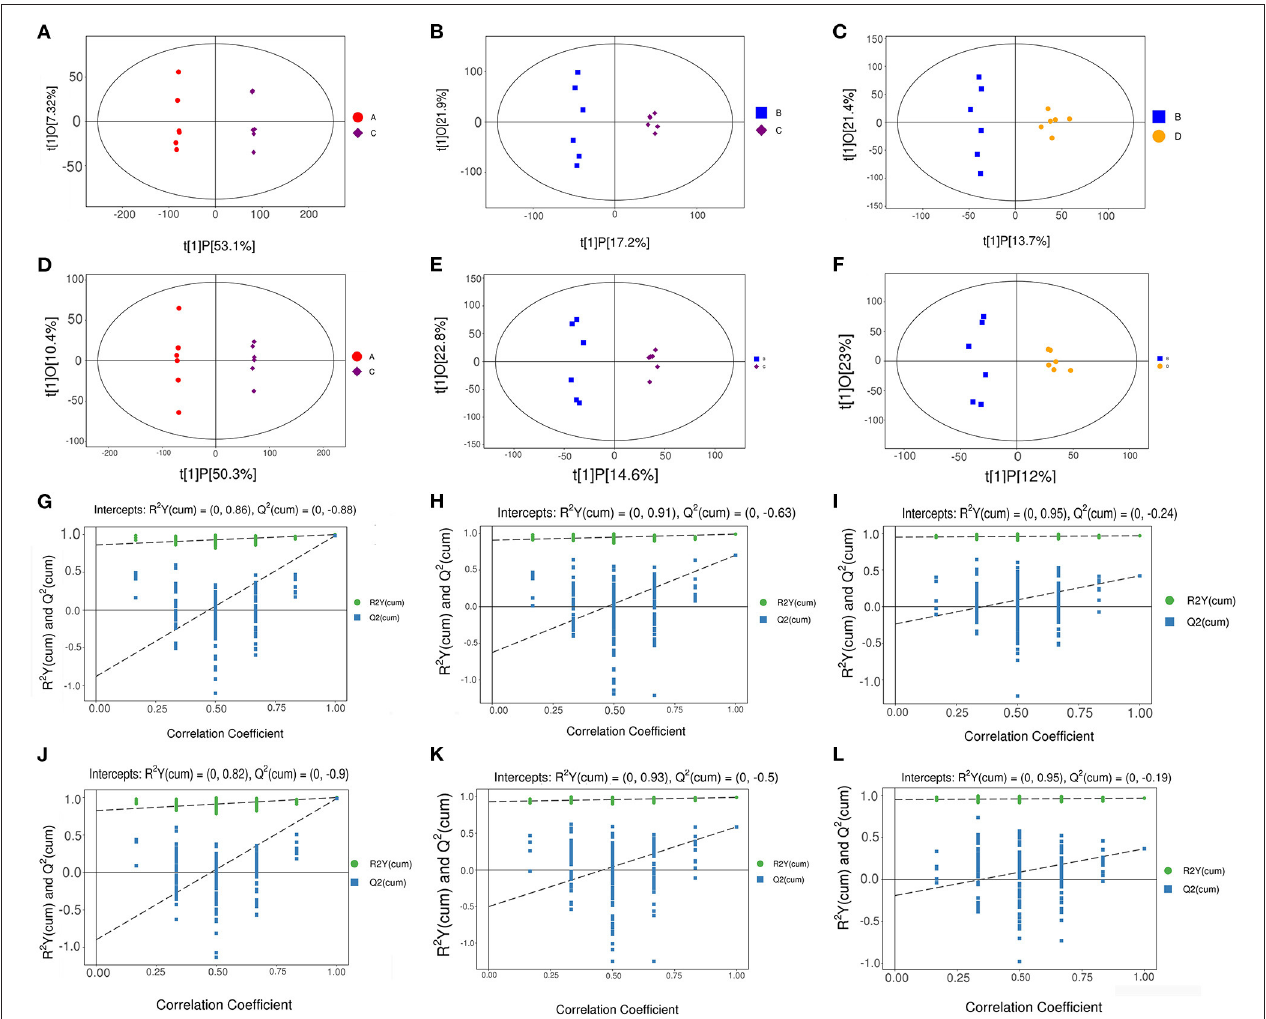
FIGURE 8 | Scatter plot of OPLS-DA model (A–F) and permutation test of OPLS-DA model (G–L) . (A–C), (G–I) : Positive ion mode; (D–F), (J–L) : Negative ion mode. (A,D,G,J) : NT-free group compared with NT intervention group; (B,E,H,K) : basal diet group compared with NT intervention group; (C,F,I,L) : basal diet group compared with model control